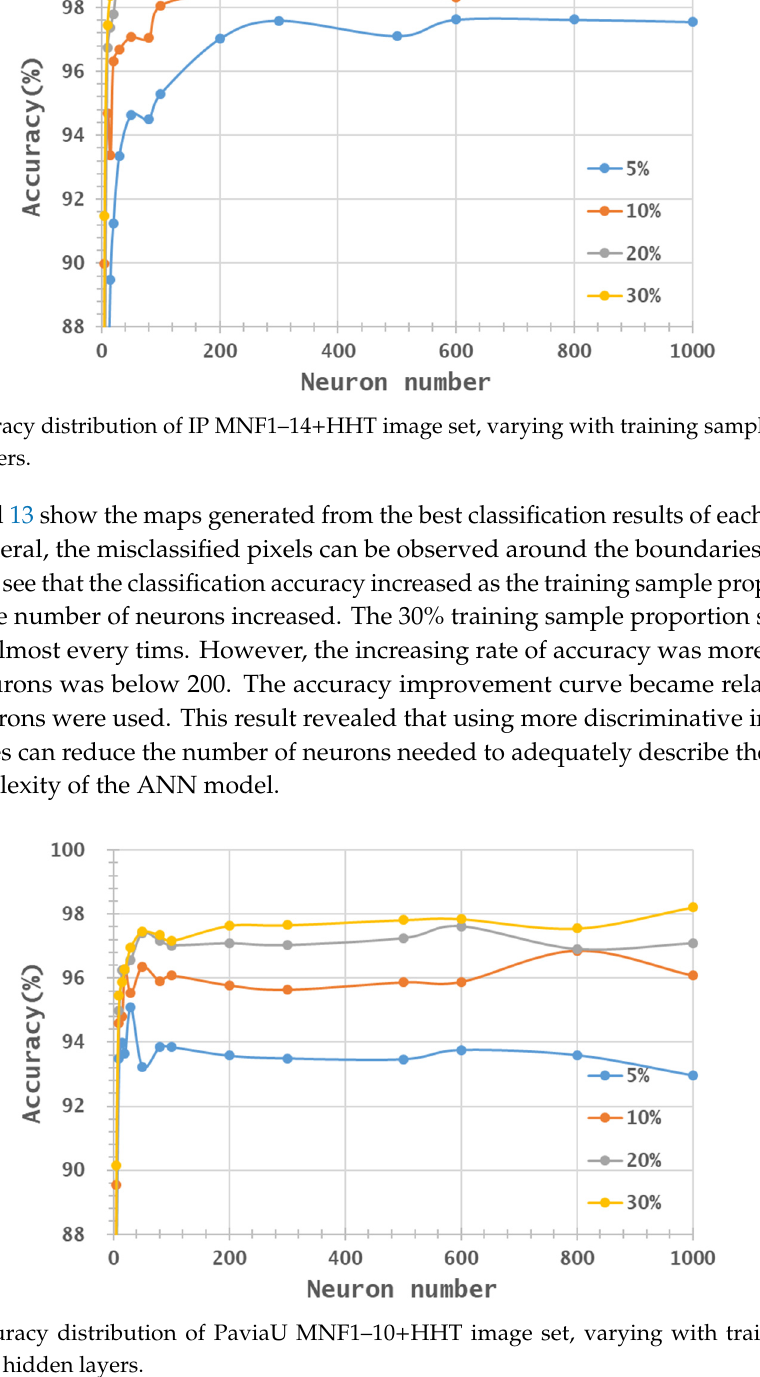
Figure 7. Accuracy distribution of IP MNF1–10+HHT image set, varying with training sample proportion and hidden layers.